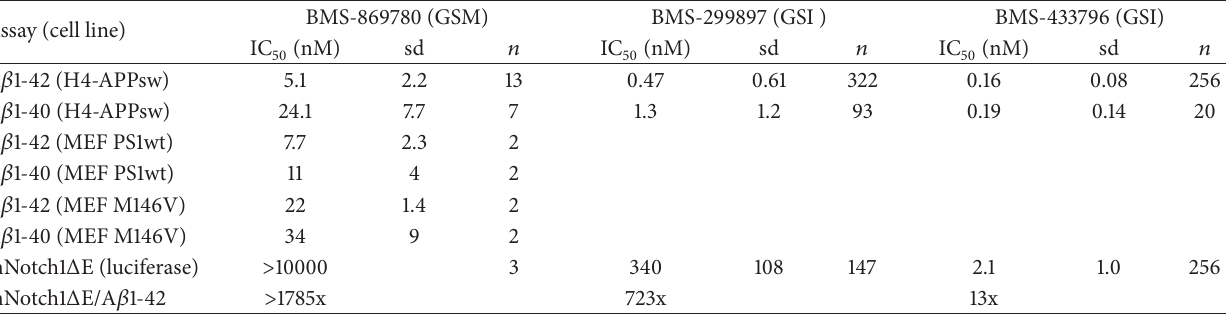
Table 1: A 𝛽 and Notch IC